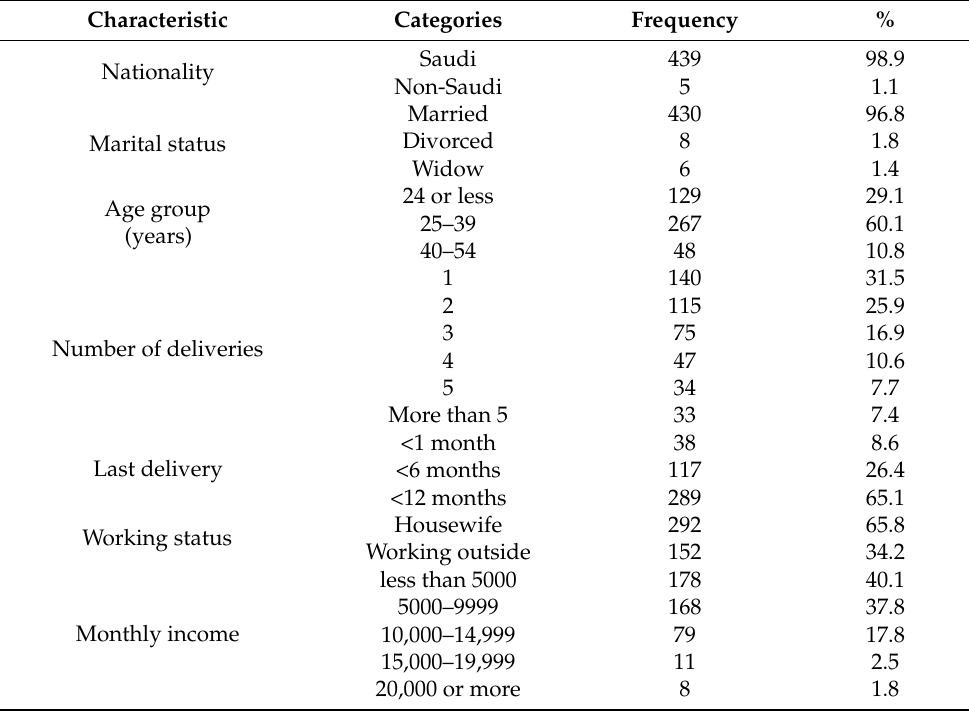
Table 1. Socio-demographic characteristics of the study sample.